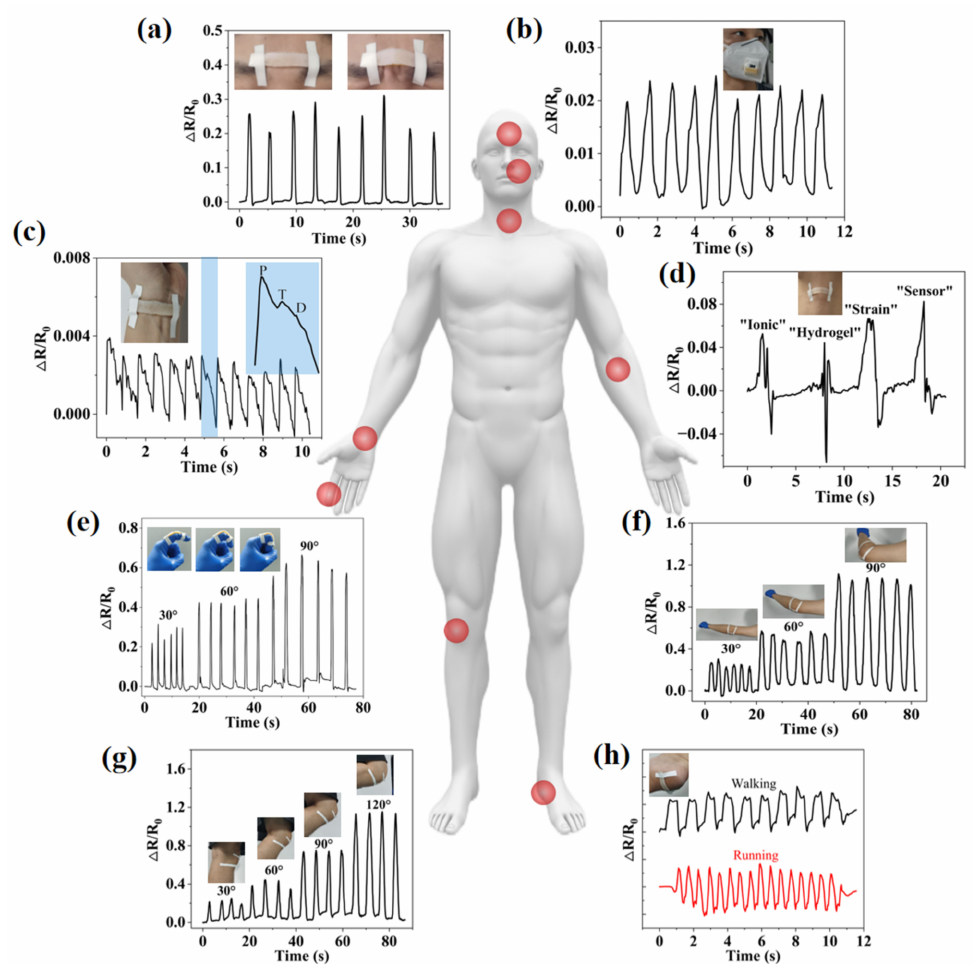
Figure 7. IHSS for real-time monitoring of human motions. ( a ) Monitoring frowning movement by installing the IHSS on the forehead. ( b ) Monitoring human breathing by integrating the IHSS on a mask. ( c ) Real-time radial artery pulse monitoring by attaching the IHSS to the wrist. The right enlarged is one complete radial artery pulse waveform containing “P”, “T”, and “D” peaks. ( d ) Sound and speech recognition by attaching the IHSS to the throat to detect its vocal-cord vibrations. ( e ) IHSS fixed on a finger that repeated bending/unbending at different angles (30 ◦ , 60 ◦ , and 90 ◦ ), ( f ) elbow (30 ◦ , 60 ◦ , and 90 ◦ ), and ( g ) knee (30 ◦ , 60 ◦ , 90 ◦ , and 120 ◦ ). ( h ) IHSS fixed on the heel to detect the foot-movement